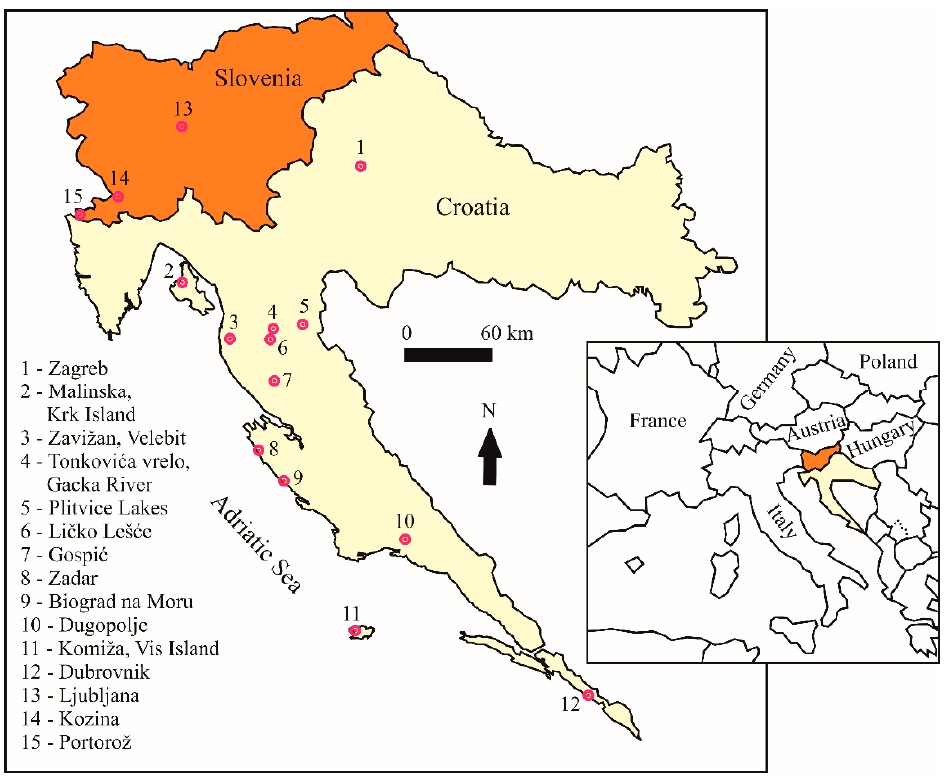
Figure 1. Map of stations with isotope-in-precipitation data in Croatia (locations 1–12) and in Slovenia (locations 13–15). Details on stations are in Table S1.